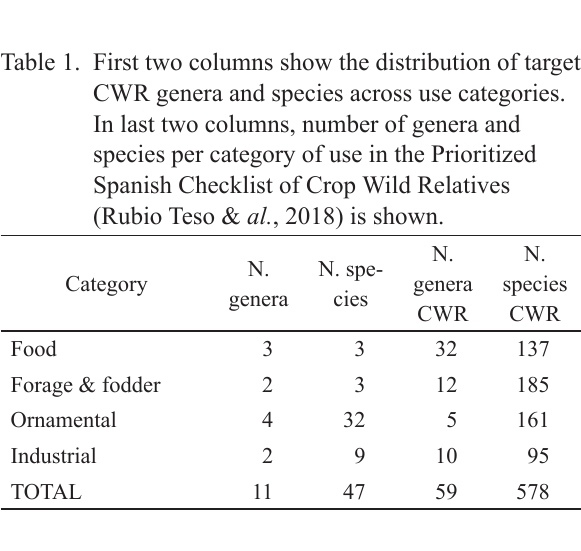
Table 1. First two columns show the distribution of target CWR genera and species across use